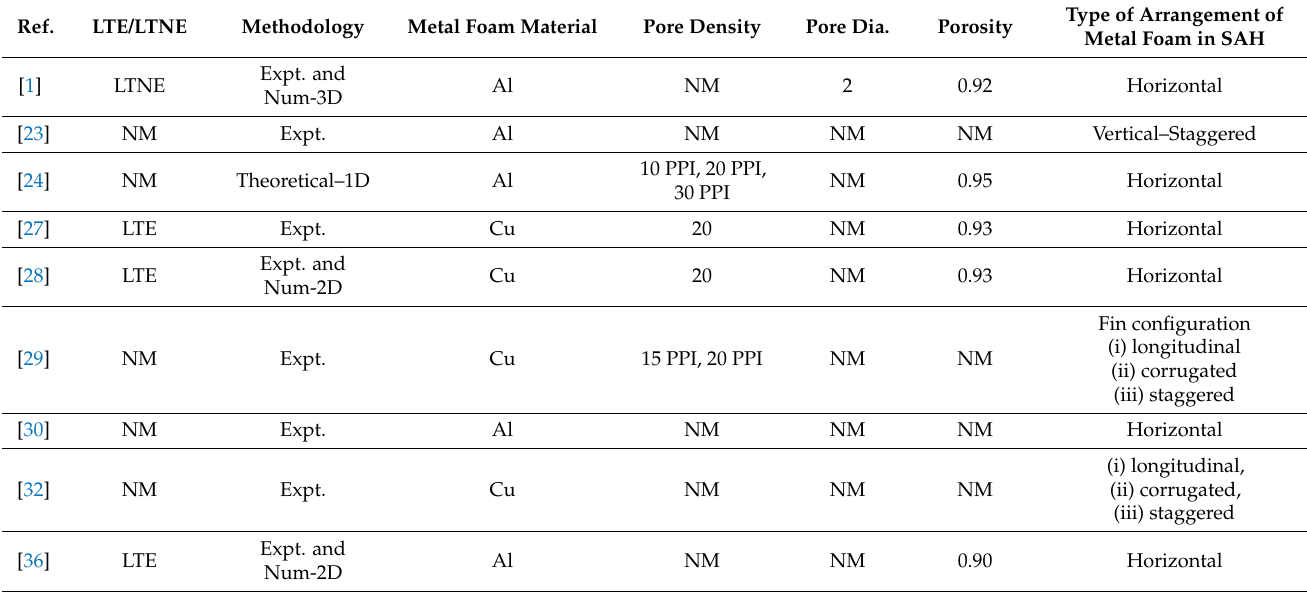
Table 1. Literature of metal foam as a porous media in solar air